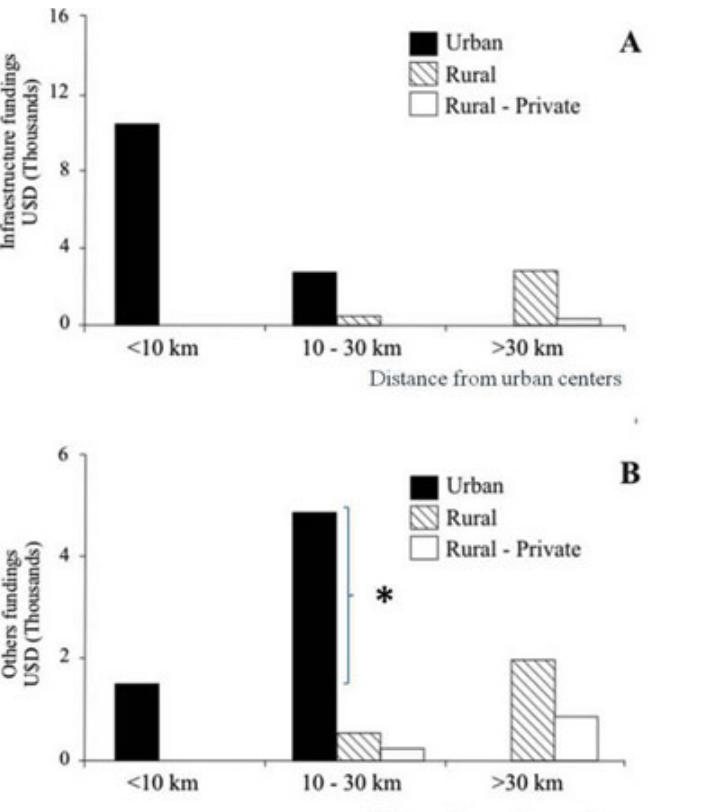
Fig. 4 . Investment according to proximity to administrative centers for (A) infrastructure investments and (B) other investments. * , the investment in